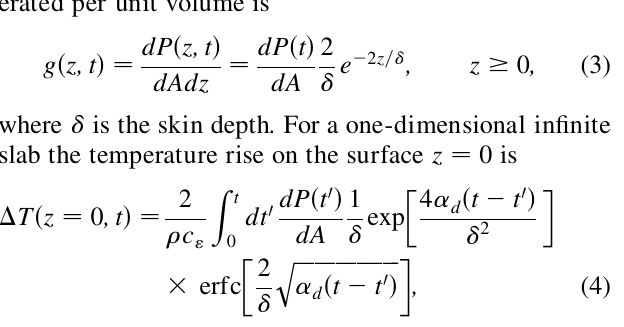
FIG. 9. Schematic of the diagnostic setup to measure pulsed temperature rise and cavity Q of the TE